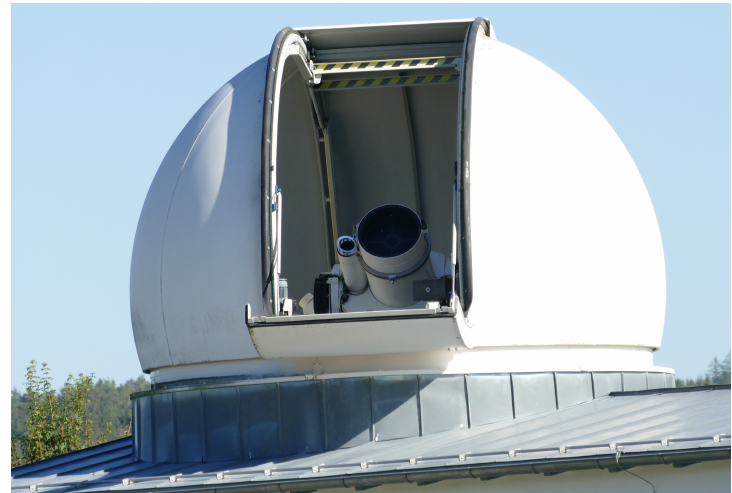
Figure 3. Satellite Observing System Wettzell with turnable protecting dome at GOW. Hexagon’s Aicon DPA Industrial measurement system is chosen for data acquisition and analysis, cf. Figure 4. The handheld digital camera-based photogrammetry system consists of the C1 camera, i.e., a Canon EOS 5D equipped with a 28 mm Aicon metric wide- angle lens that is protected by a robust and extremely stiff IP51-rated camera case, and the analysis software Aicon Studio 3D. The maximum permissible error (MPE) of a measured length, which is located between two signalized points, is specified by 15 µm + 15 µm m − 1 . The typical standard deviation of a position-based measurement obtained by a bundle (cid:113) + ¯ σ 2 + ¯ σ 2 ¯ σ 2 adjustment, i.e., ¯ σ 3D = , is stated by 2 µm + 5 µm m − 1 [45]. Investigations X Z Y on the geometric stability of the camera can be found in Rieke-Zapp et al. [46].